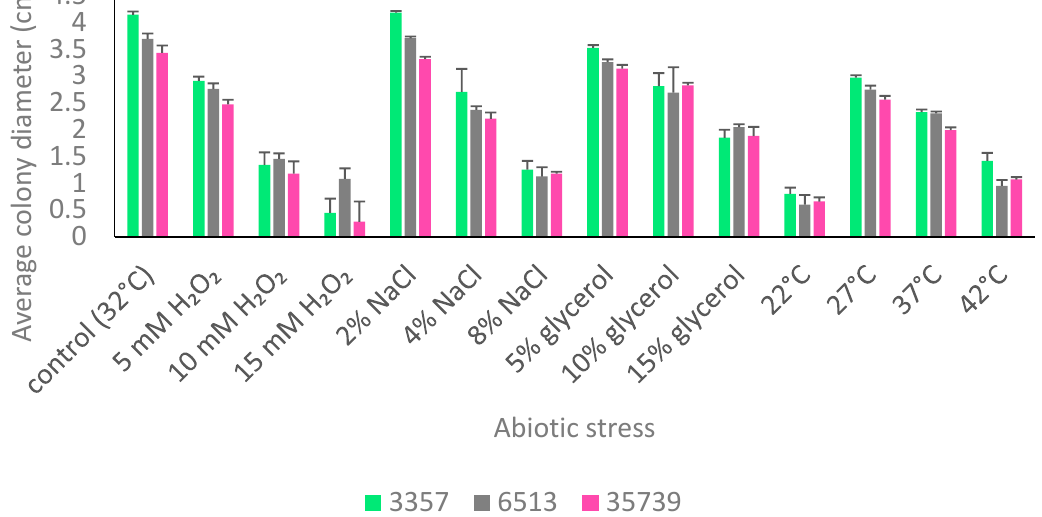
Figure 2. Abiotic stress tolerance of A. flavus NRRL 3357, NRRL 6513, and NRRL 35739. Cultures were grown on solid YES media amended with the indicated stress agents. Colony diameters were measured after two days. Error bars represent one standard deviation above the mean of four replicates.